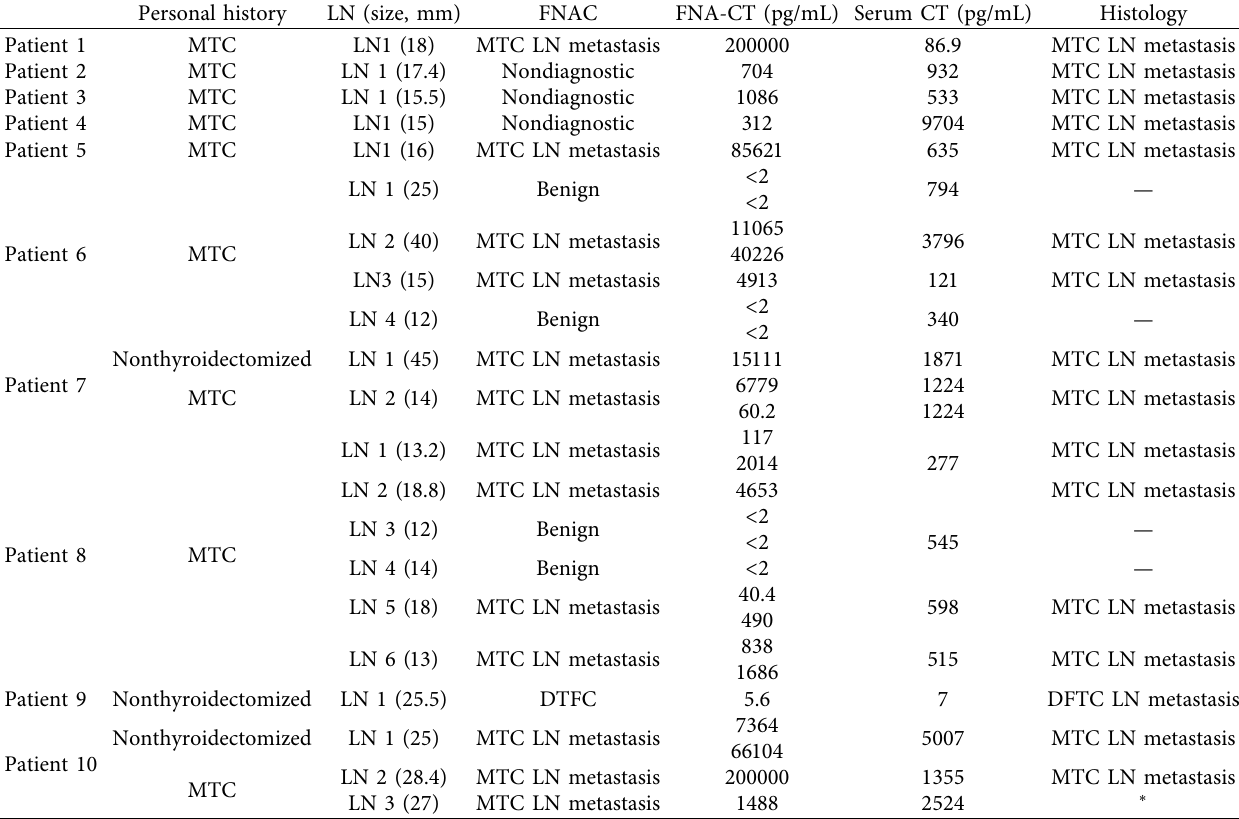
Table 2: Patients with detectable levels of FNA-CT in LN washout fluid (available as a supplementary